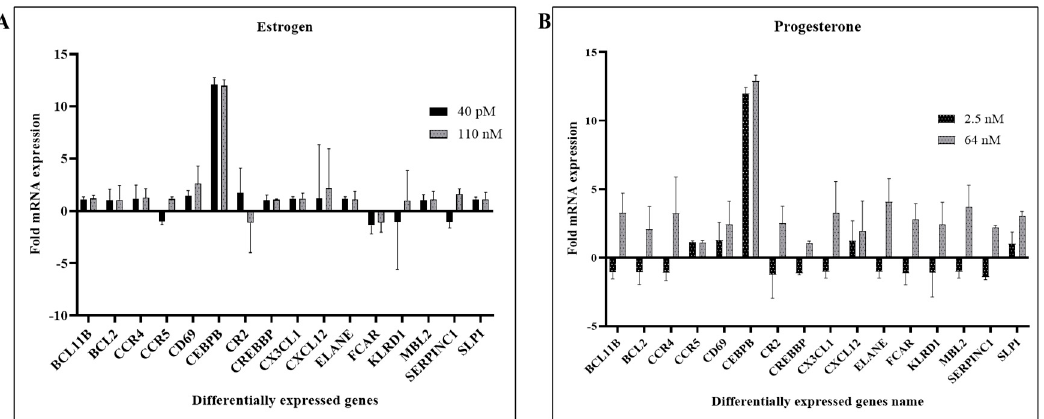
Figure 1. Differentially Expressed Genes in Estrogen or Progesterone Treated MDMs Infected with HIV-1; MDMs (10 × 10 6 cells/flask) were pre-treated with estrogen (40 pM and 110 nM) or proges- terone (2.5 nM and 64 nM) and infected with HIV-1 (BaL). After 2 h, the virus was removed, and fresh culture media added with same concentration of estrogen (40 pM and 110 nM) or progesterone (2.5 nM and 64 nM) and cultured. MDMs were collected 9 days post infection. RT 2 Profiler PCR Array was used to examine the mRNA levels of different HIV-1 host response genes. Assays were performed with experimental RNA samples isolated from MDMs obtained from 3 independent donors. Data was analyzed with average Ct values (Table S1) using Qiagen web-based software (RT 2 Profiler PCR Array Data Analysis) and results expressed as mean ± SD; ( A ) Differentially expressed genes in estrogen treated MDMs infected with HIV-1 BaL; ( B ) Differentially expressed genes in progesterone treated MDMs infected with HIV-1